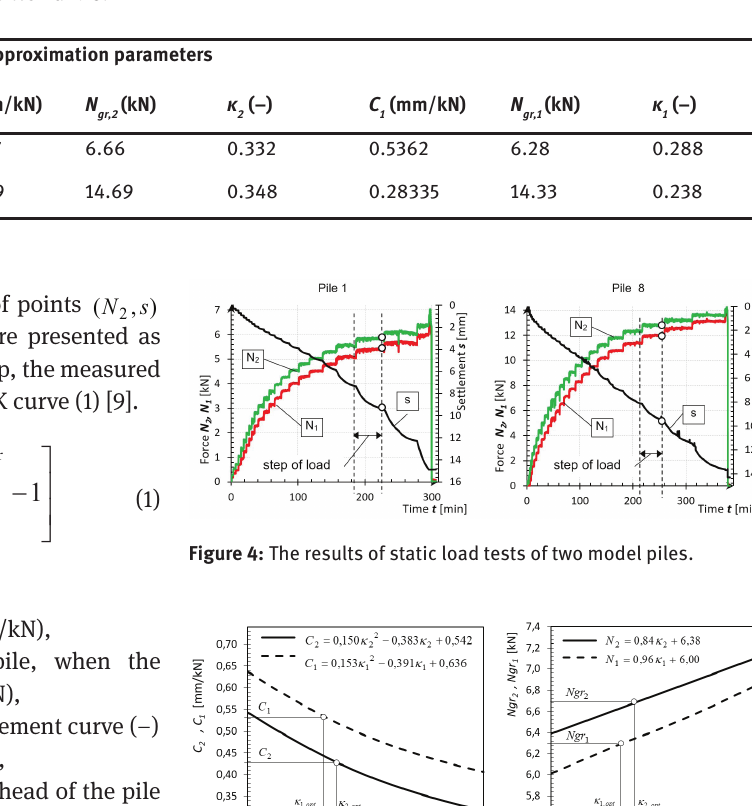
Table 1: Comparison of the M-K approximation of piles 1 and